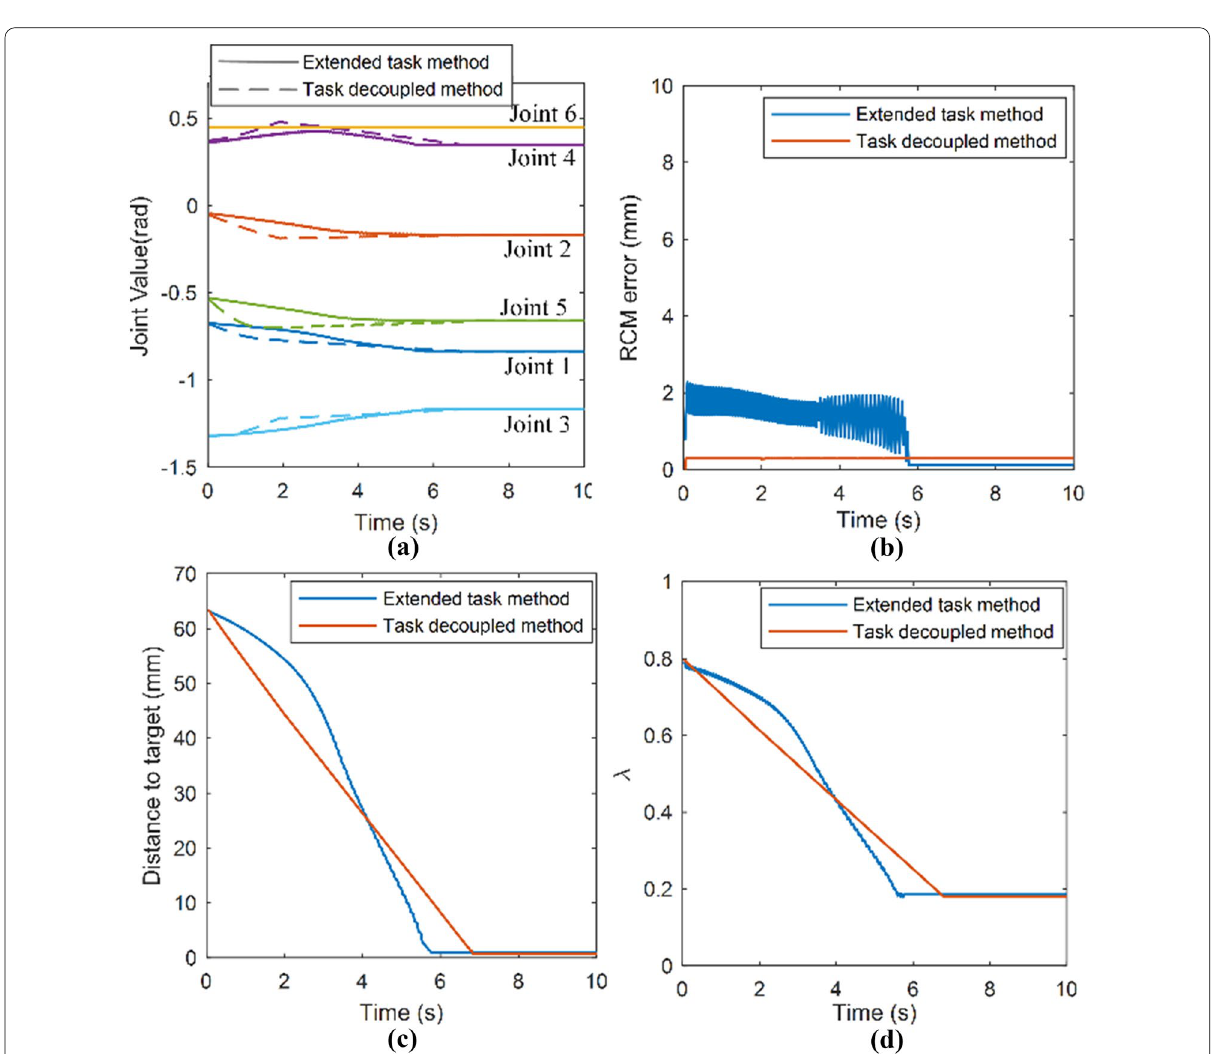
Figure 12 Simulation results for robot to reach target with RCM constraint using two different